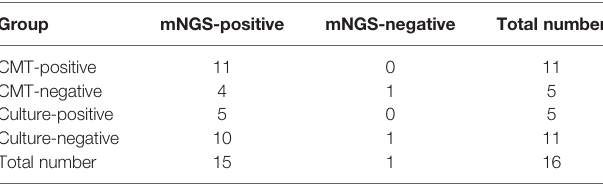
TABLE 2 | Comparison of positive results and agreement among mNGS, CMT and culture method in patients.